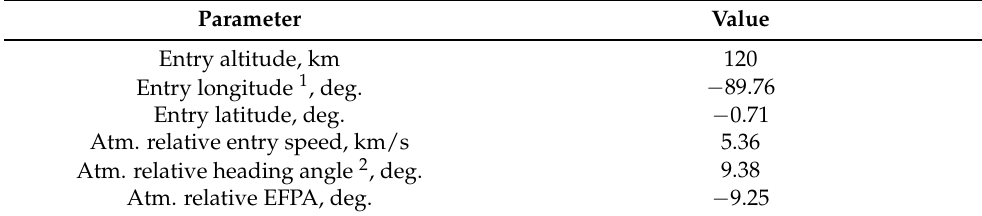
Table 1. Mars aerocapture vehicle atmospheric entry